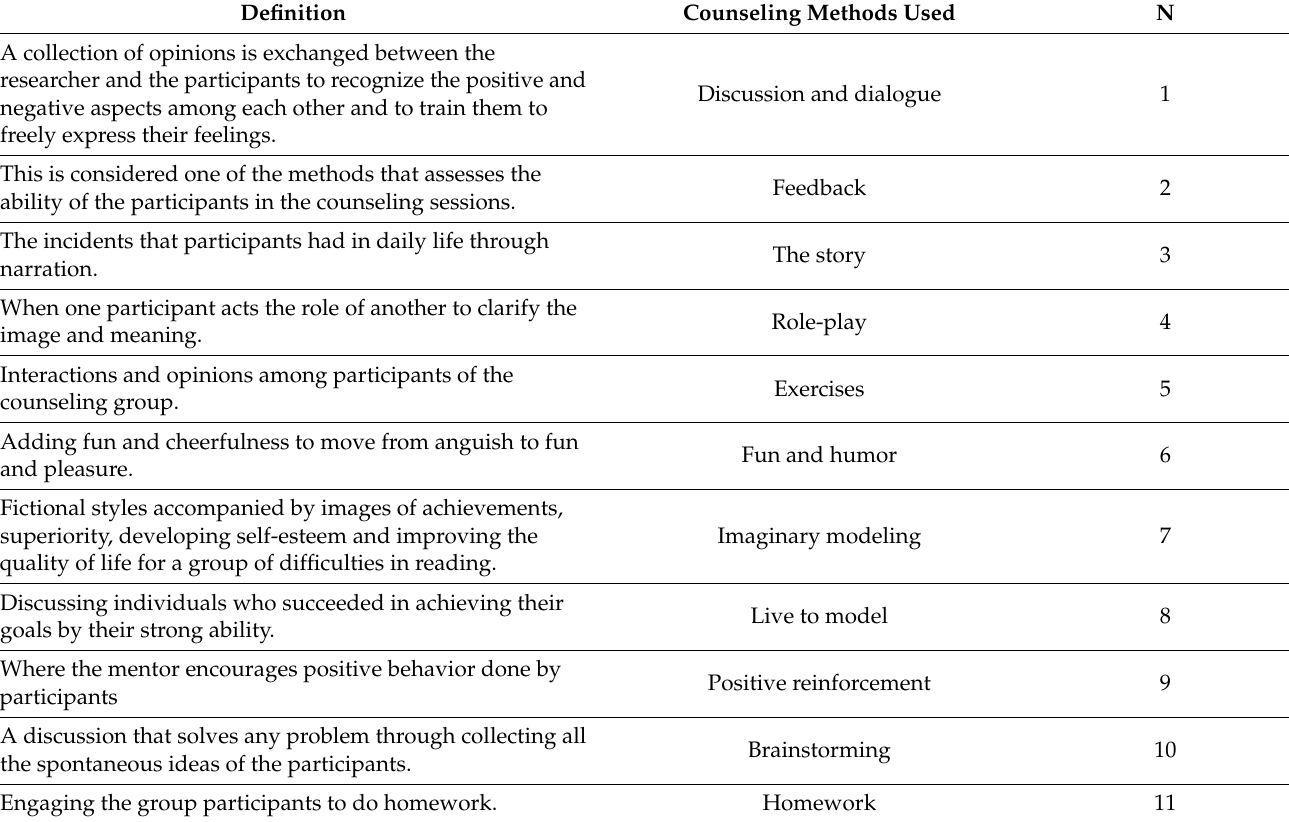
Table 2. Counselling methods used in the